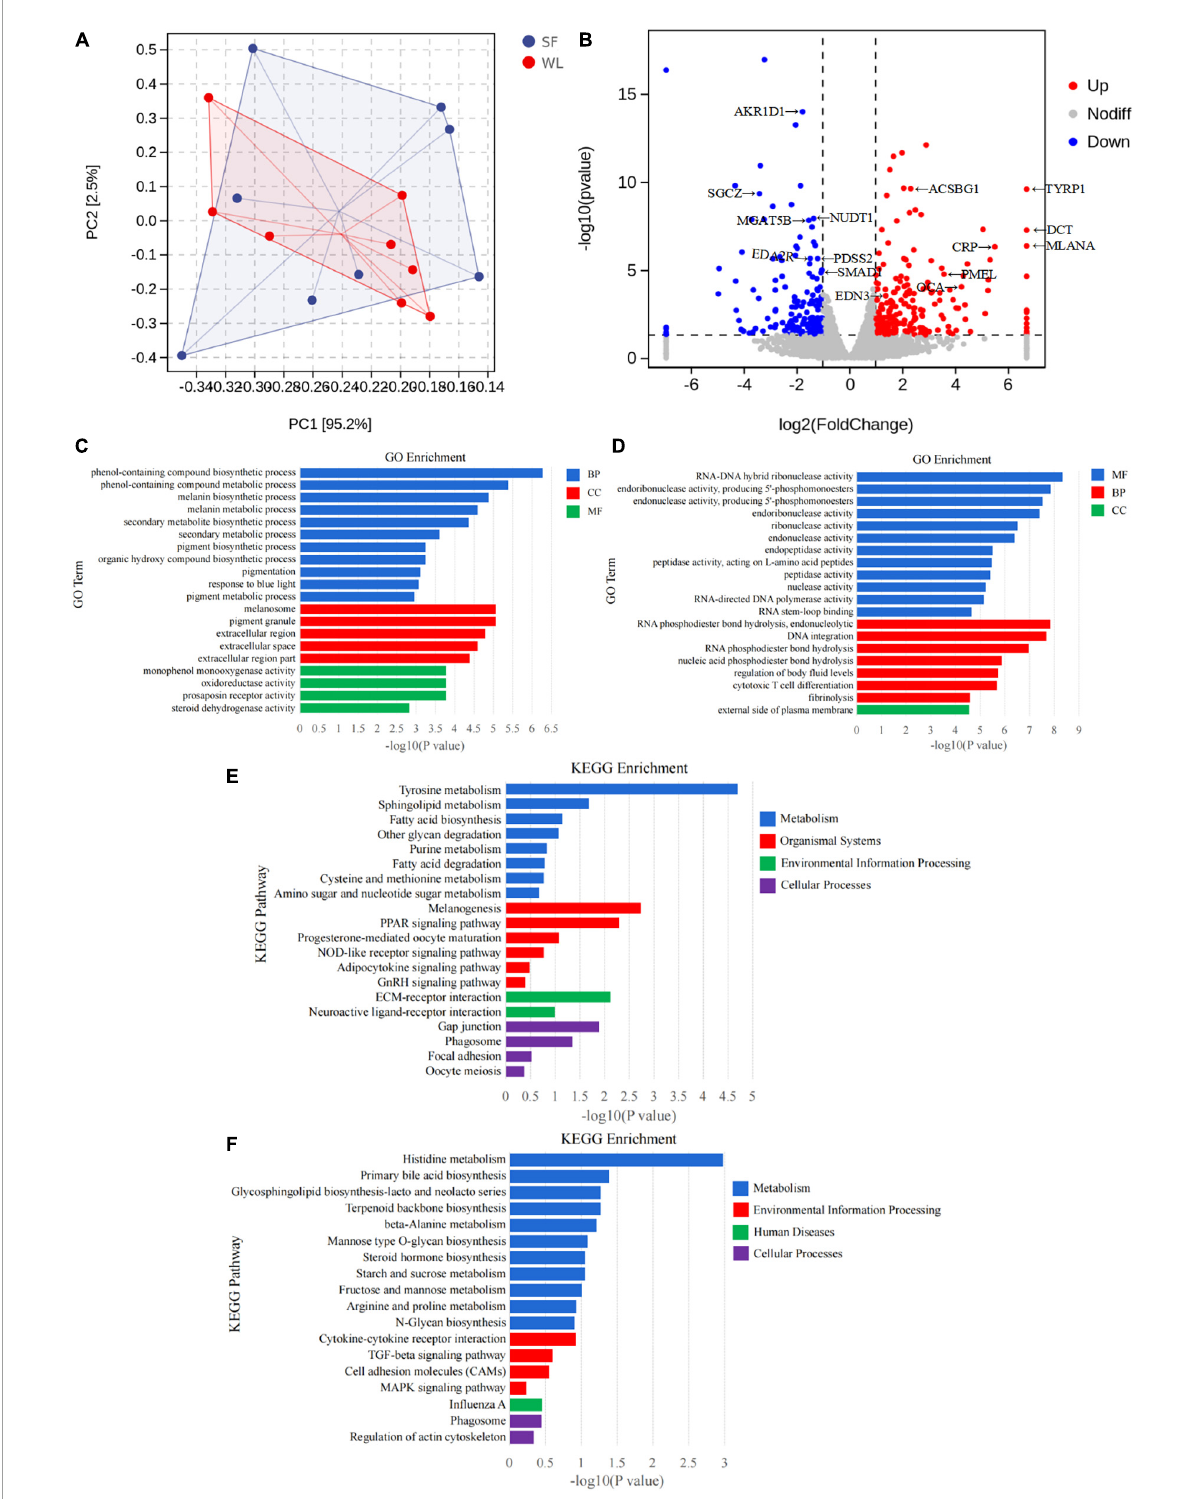
FIGURE4 Differential characterization of cecum gene expression in hosts. (A) PCA map of cecal intestinal wall transcriptome. (B) Differential expression volcano plot in the cecal transcriptome of SF and WL. (C) GO classification of the up-regulated expressed genes of SF. (D) GO classification of the up-regulated expressed genes of WL. (E) KEGG classification of the up-regulated expressed genes of SF. (F) KEGG classification of the up-regulated expressed genes of